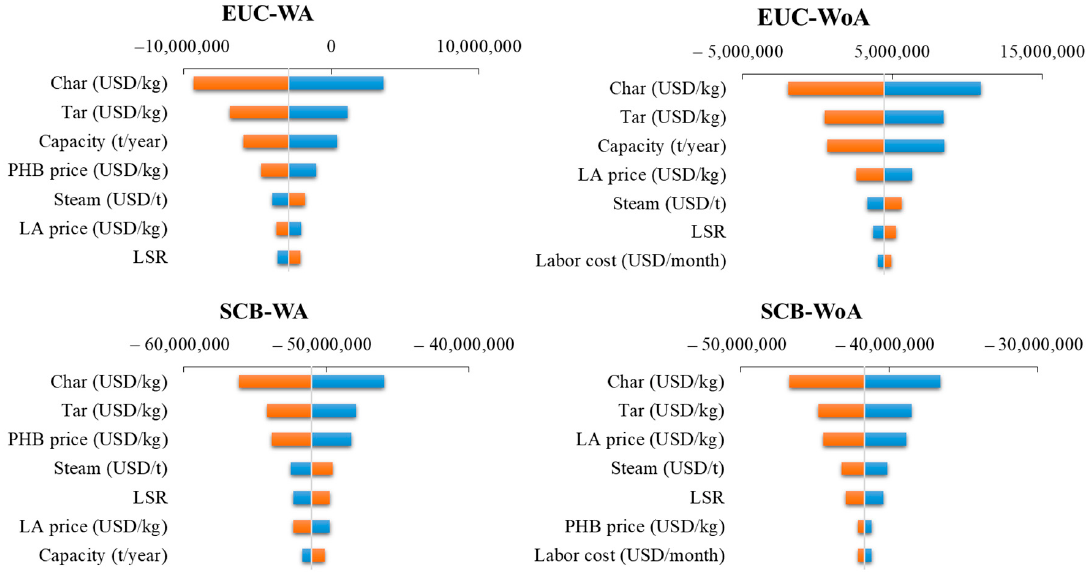
Figure 8. Results of the sensitivity assessment for the selected scenarios. WA: with acetate. WoA: without acetate.